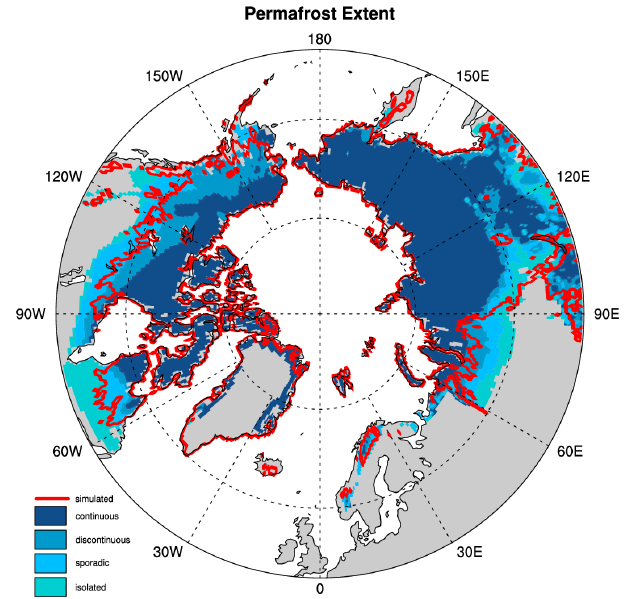
Fig. 8. Northern Hemisphere permafrost extent according to the In- ternational Permafrost Association’s permafrost map (Brown et al., 2002). Different permafrost classes are plotted in different colors and the red line shows the border of the permafrost extent calcu- lated from the JSBACH simulation (1980–1990 average values).